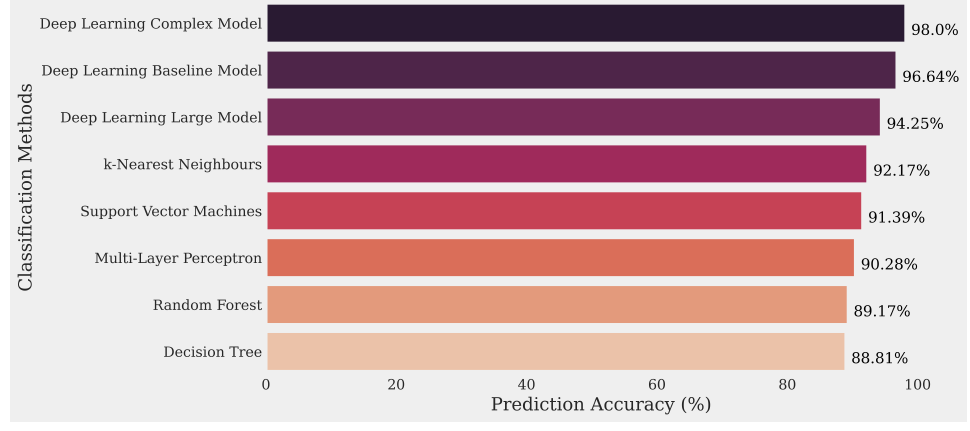
Figure 5. Bar plot representing the cross-validation classification accuracies for different deep learning and machine learning models. Description of each model and its associated property are mentioned in Table 4. Table 4. Deep learning and machine learning models with their properties. Model